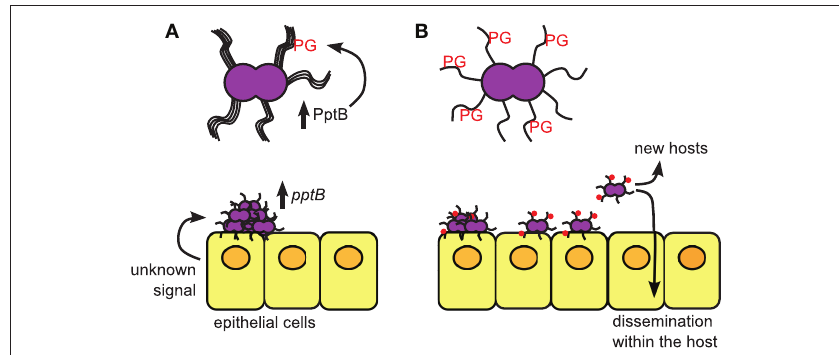
Figure 1 | The role of PptB in mediating meningococcal dissemination. (A) Bacteria growing on the epithelial cell surface in microcolonies are induced to express PptB after host cell contact, which induces addition of phosphoglycerol (PG) onto pilin subunits. (B) Bacteria whose pili have been PG-modified lose their aggregative properties due to loss of pilus bundling, and begin to detach from the microcolonies. Detached bacteria can then move to different sites within the same host, or be transmitted to new